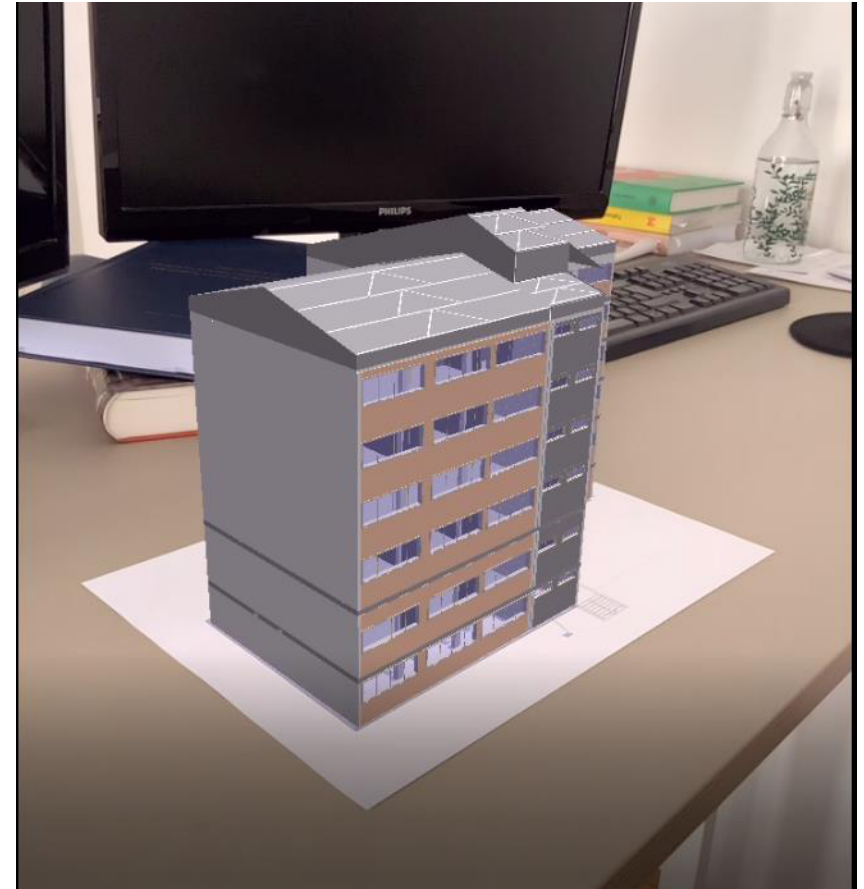
Figure 16. Scaled-down BIM model in augmented reality.